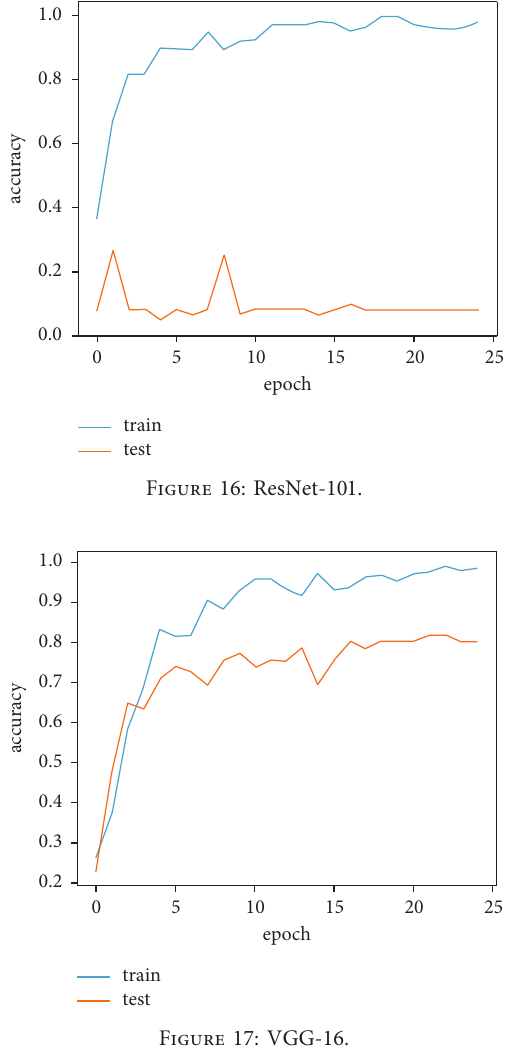
Figure 17: VGG-16.